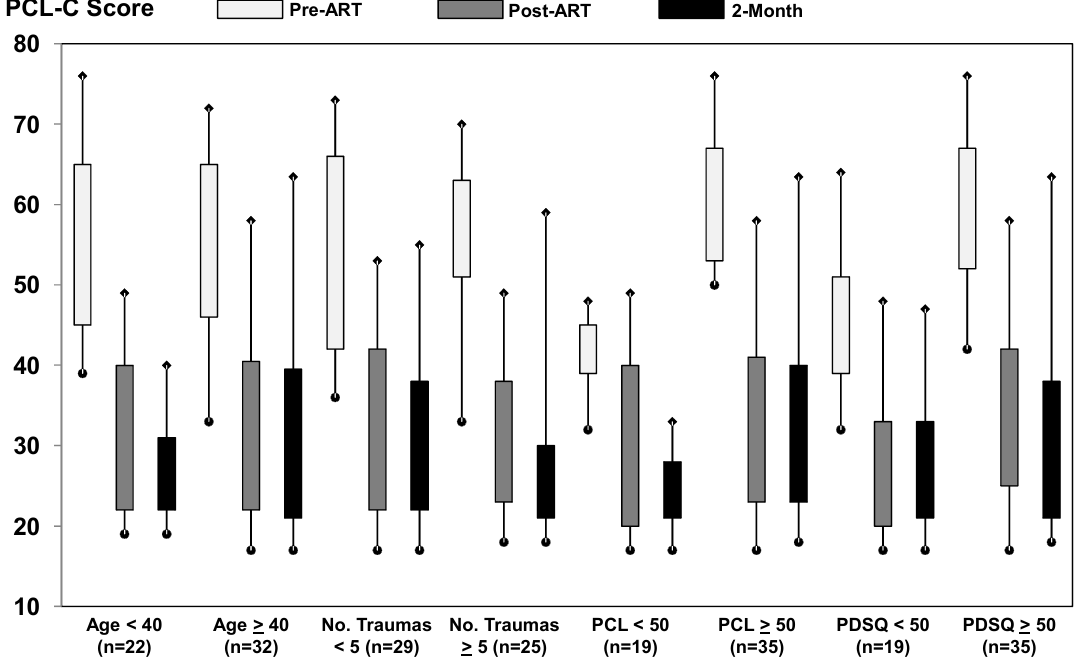
Figure 2. Distribution of self-report scores on the PCL-C among subgroups at baseline, post-treatment, and 2-month follow-up. The rectangles depict the interquartile range; the lower and upper ends of the vertical lines with the diamonds depict the 5th and 95th percentiles, respectively.